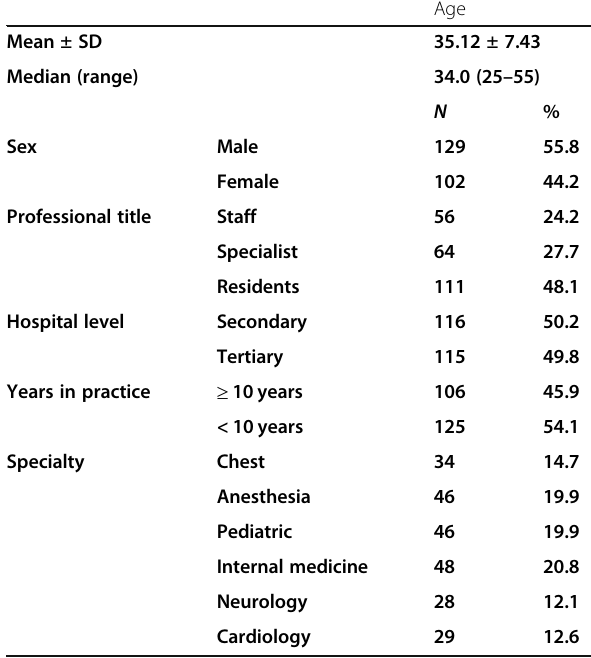
Table 1 Demographic data of all participants (no. =